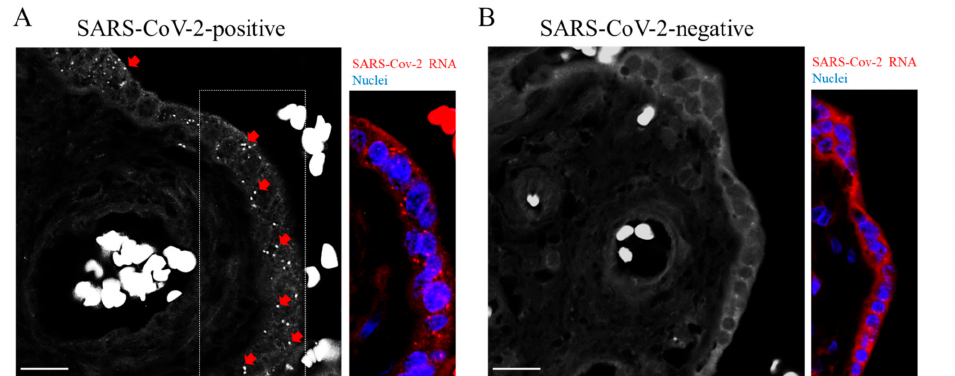
Figure 2. Detection of SARS-CoV-2 RNA. ( A , B ) Representative images of padlock assay targeting the SARS-CoV-2 RNA in sections from the placenta. ( A ) Genomic and subgenomic regions of SARS- CoV-2 were detectable following fluorescence microscopy in the SARS-CoV-2 positive placenta (red arrows and dots in a selected area of the corresponding color panel). Nuclei were labelled with DAPI (blue). ( B ) No specific signals were detectable in sections from the SARS-CoV-2 negative placenta. Scale bar, 20 µ